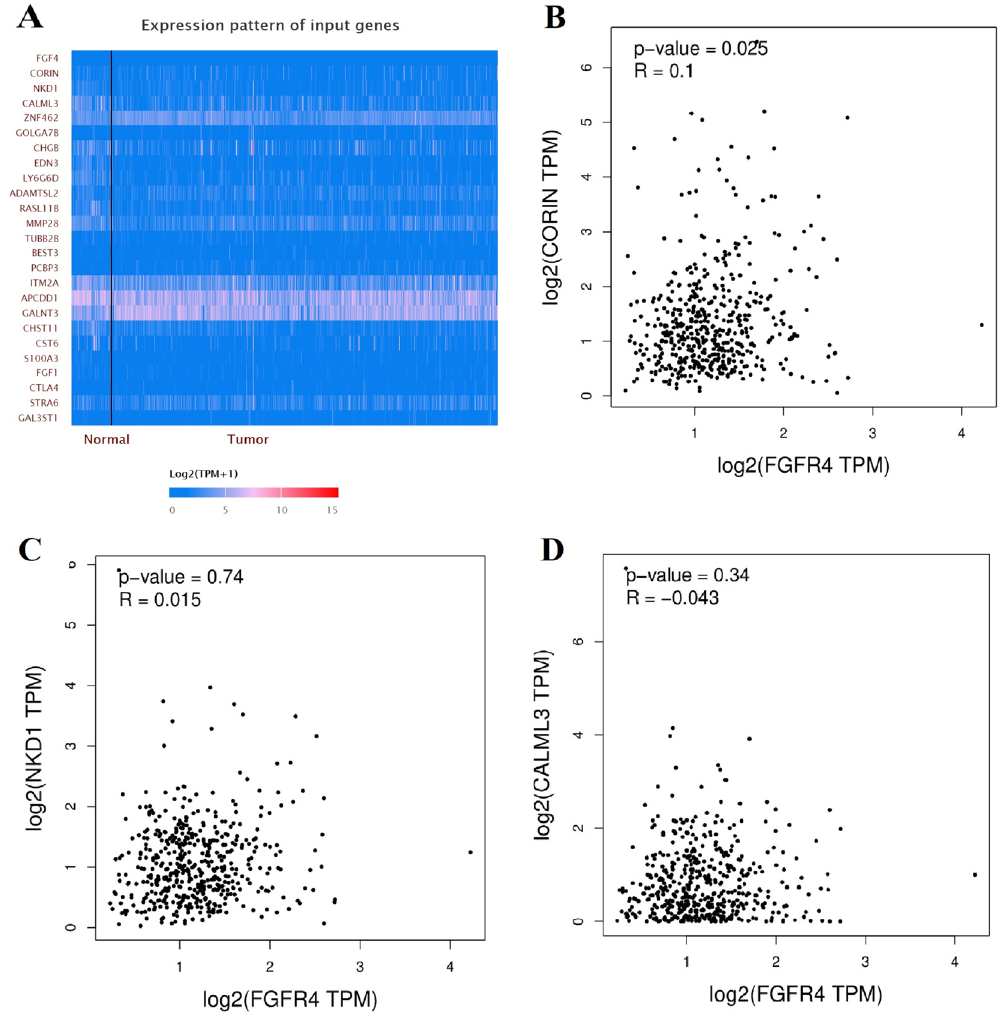
Figure 7. Gene–gene interaction of FGFR4 in prostate cancer ( A ). Correlation analysis by TCGA samples show that CORIN (corin, serine peptidase, B ) is predicted to positively correlated with FGFR4 . The interaction between NKD1 (Naked1, NKD inhibitor of WNT signaling pathway 1) and FGFR4 is shown in ( C ). The correlation between CALML3 (calmodulin like 3) and FGFR4 is described in ( D ).